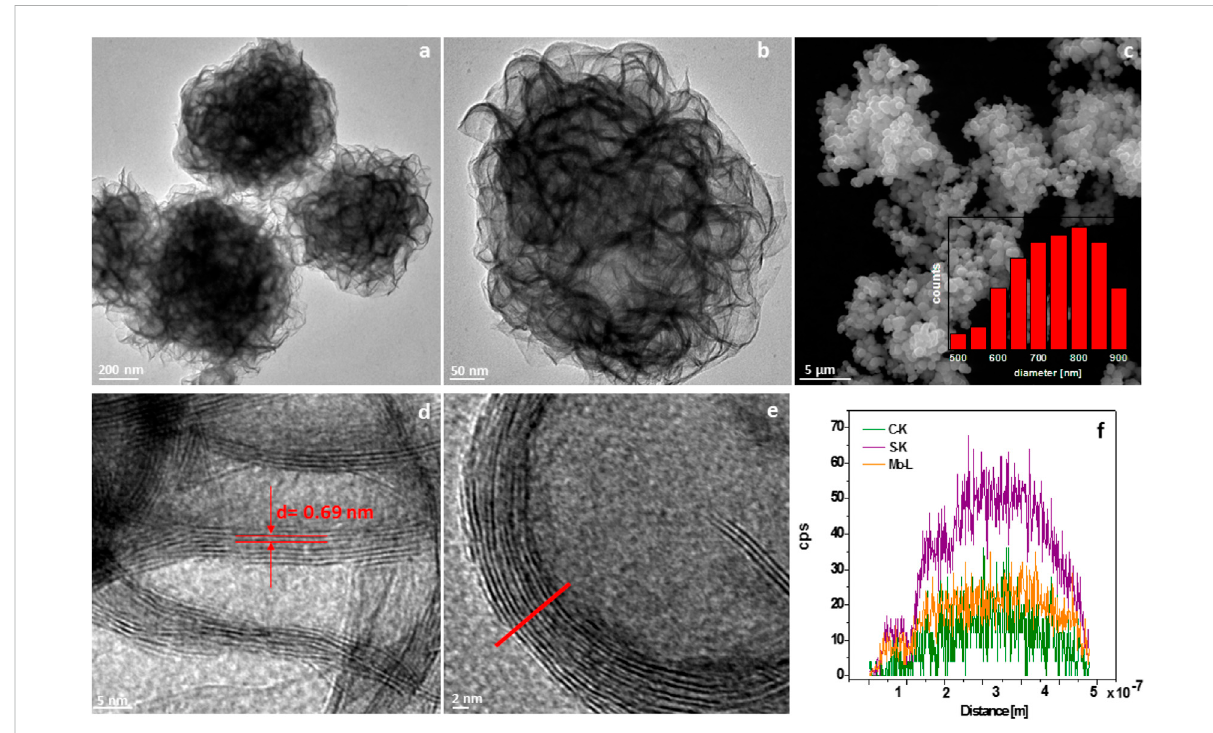
FIGURE 2 TEM images (A,B) , SEM image (C) , HRTEM images (D,E), and line pro fi le (F) of GO/MoS 2